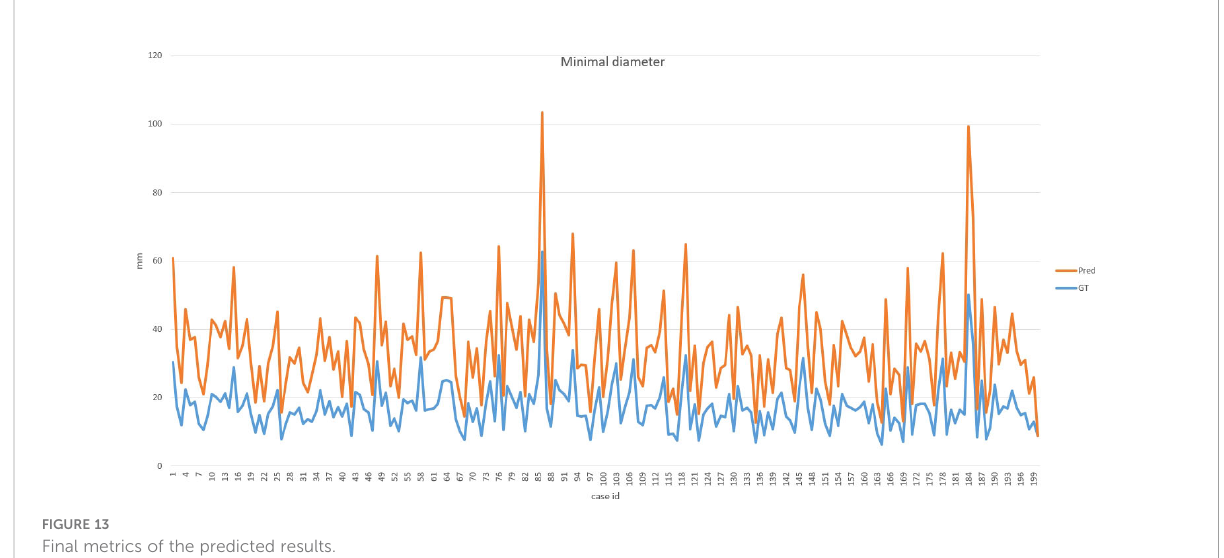
FIGURE 13 Final metrics of the predicted